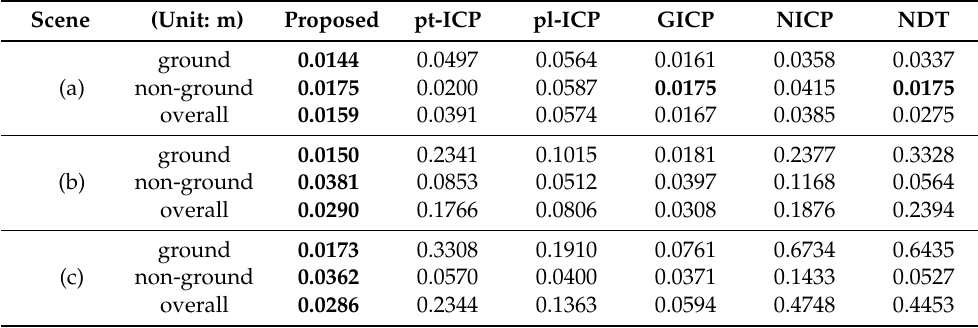
Table 1. Root mean square errors of the plane correspondences. (a) A robotic system, (b) vehicular system ( R to S 1), (c) vehicular system ( R to S